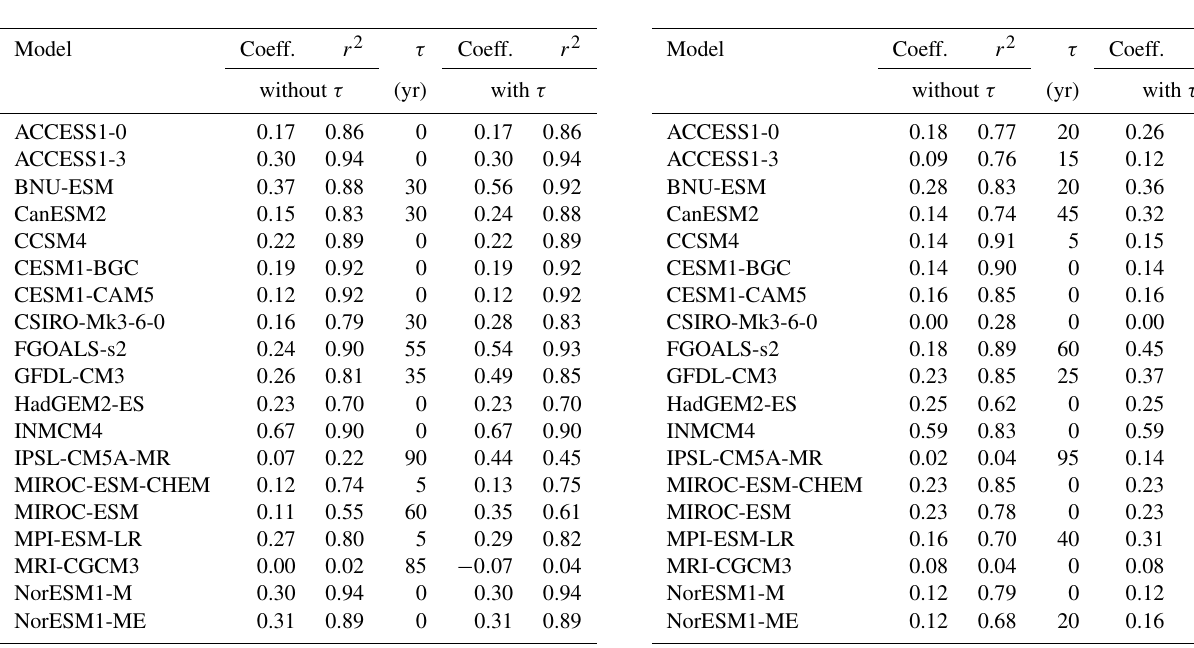
Table 5. Weddell Sea sector and Antarctic Peninsula: scaling co- efficients, α r , and time delay, τ r , between increases in global mean temperature and subsurface ocean temperature